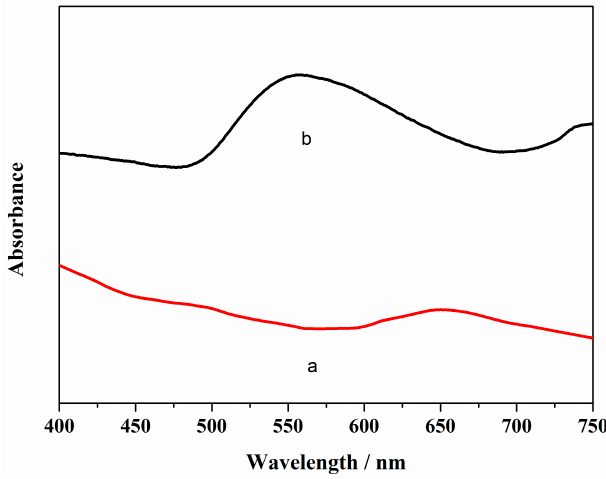
Figure 1. TEM images of Gr ( a ) and Au nanoparticles (AuNPs)/Gr ( b ).